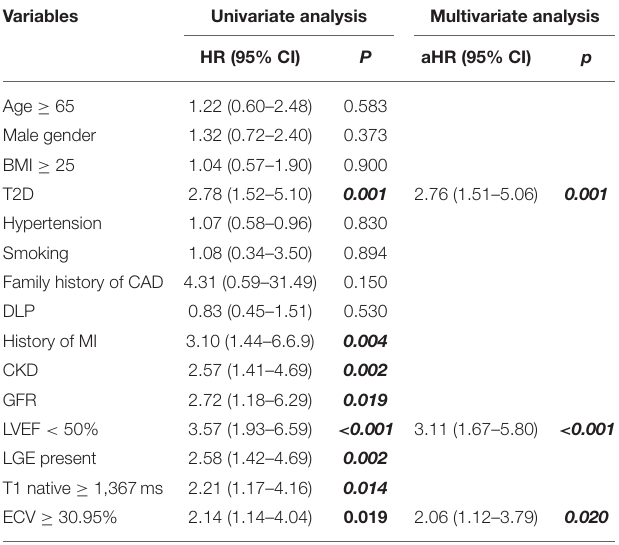
TABLE 2 | Baseline demographic and clinical data of all patients, and compared between those with and without cardiovascular composite outcome. Variables